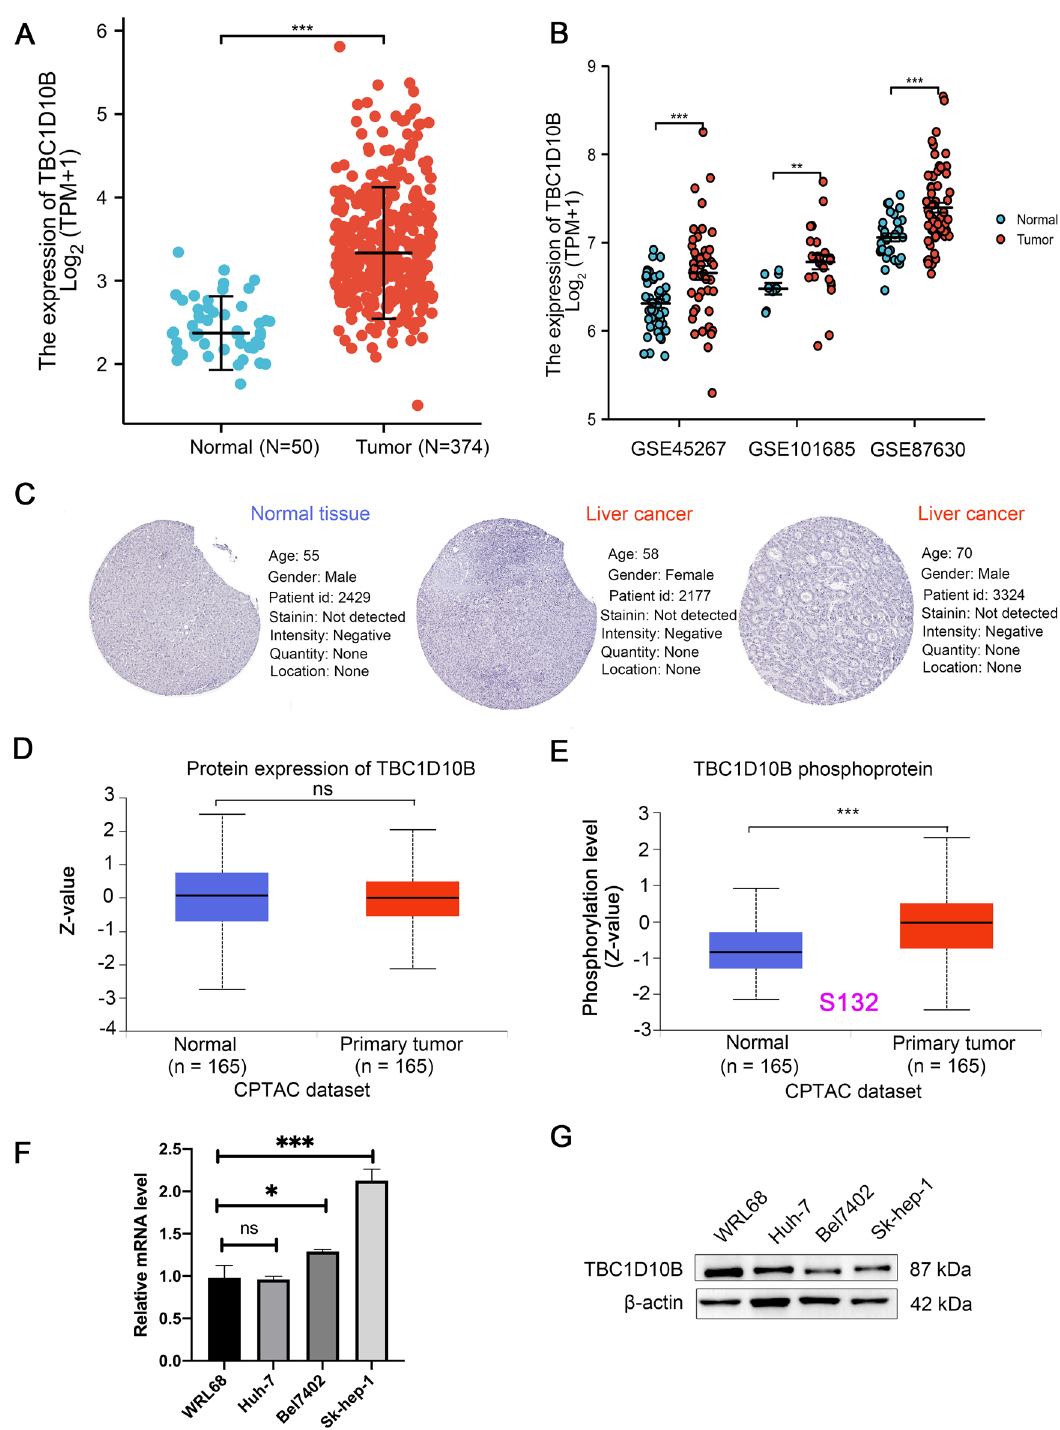
Figure 2. The mRNA and protein expression of TBC1D10B in LIHC. ( A ) Expression of TBC1D10B mRNA in 50 LIHC and 374 adjacent normal samples. ( B ) The mRNA expression of TBC1D10B in GEO database (GSE45267, GSE101685 and GSE87630). ( C,D ) The protein expression levels of TBC1D10B based on CPTAC and HPA database. ( E ) The expression level of TBC1D10B phosphoprotein (NP_056342.3, S132 site) between primary liver cancer tissue and normal tissue was analyzed via UALCAN. ( F,G ) mRNA levels ( F ) and protein levels ( G ) of TBC1D10B in human hepatoma cell lines (Huh-7, Bel7402 and Sk-hep-1) and non-tumor human embryo liver cell (WRL68) were determined by q-RT-PCR and Western blotting. * P < 0.05; *** P <